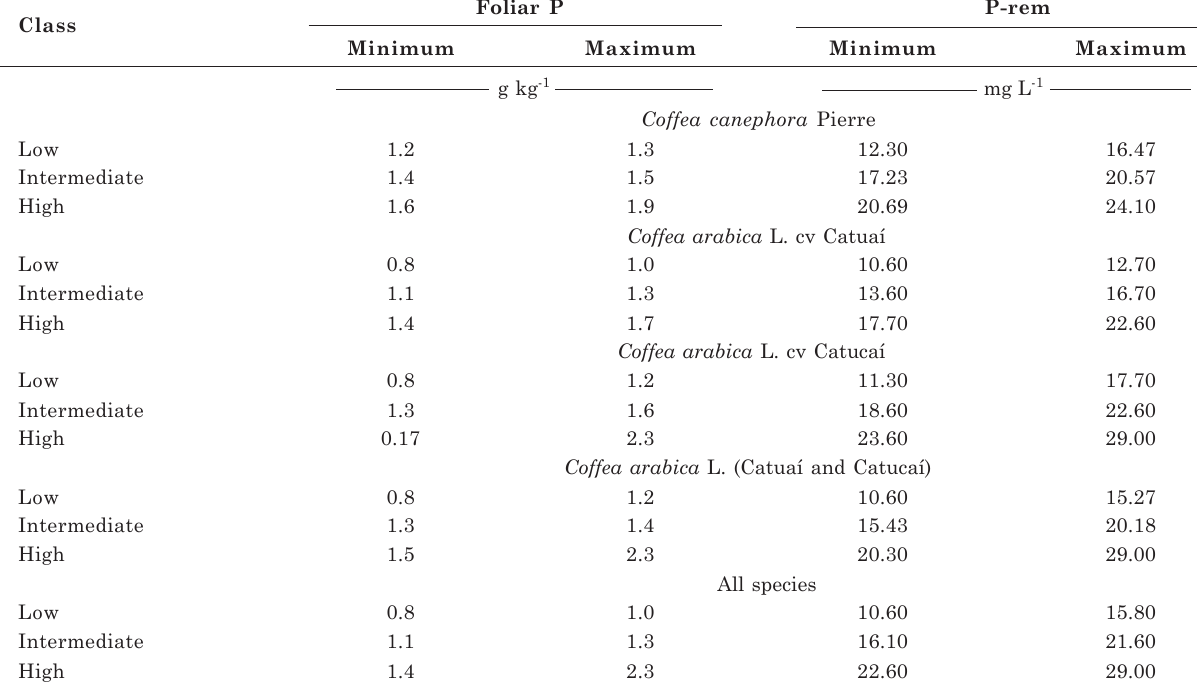
Table 4. Classes and limits as defined by cluster analysis for foliar phosphorus and remaining phosphorus